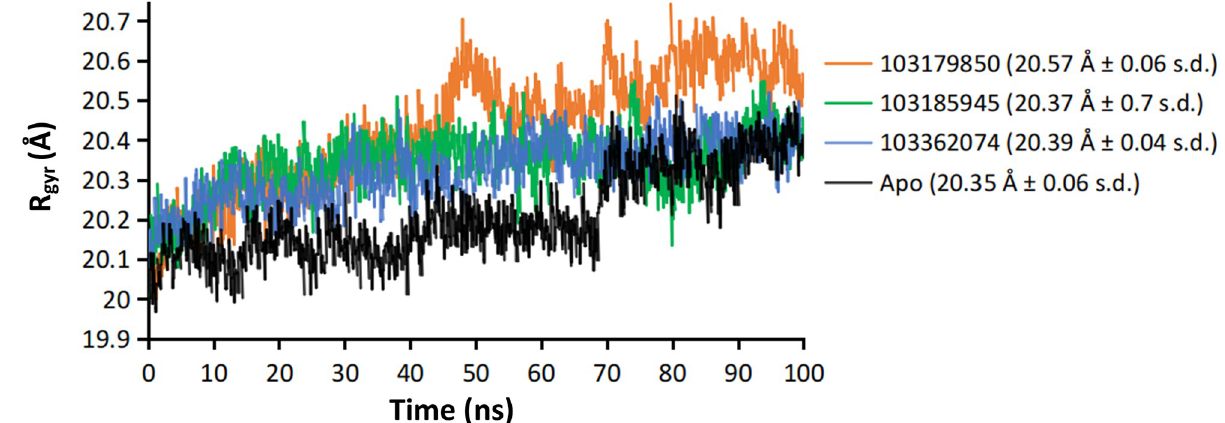
Fig 10. Time series plot of radius of gyration of HDAC2 protein in unbound and ligand-bound form; Average values (in parenthesis) are approximated for relatively equilibrated frames of 60ns and beyond.